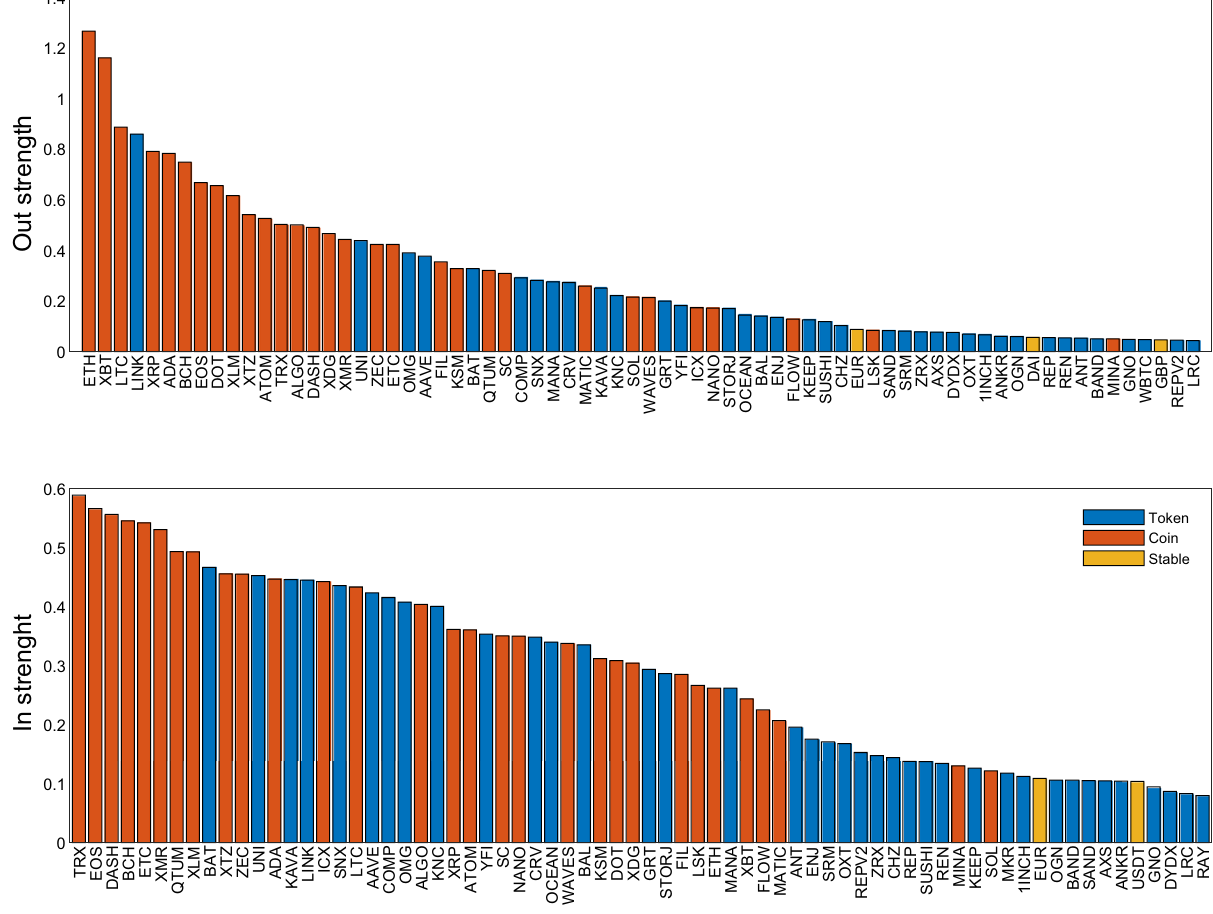
Figure 2. The most important nodes in the network of pairwise Granger causality. Top panel shows the total out strength for the first 70 most influential cryptocurrency, cumulated over the considered two years period. In the same fashion, the bottom panel depicts the in strength of the first 70 most influenced nodes, cumulated over the 104 weekly windows, thus indicating the most influenced nodes of the network. Yellow bars indicate stable- coins, red bars coins and blue bars